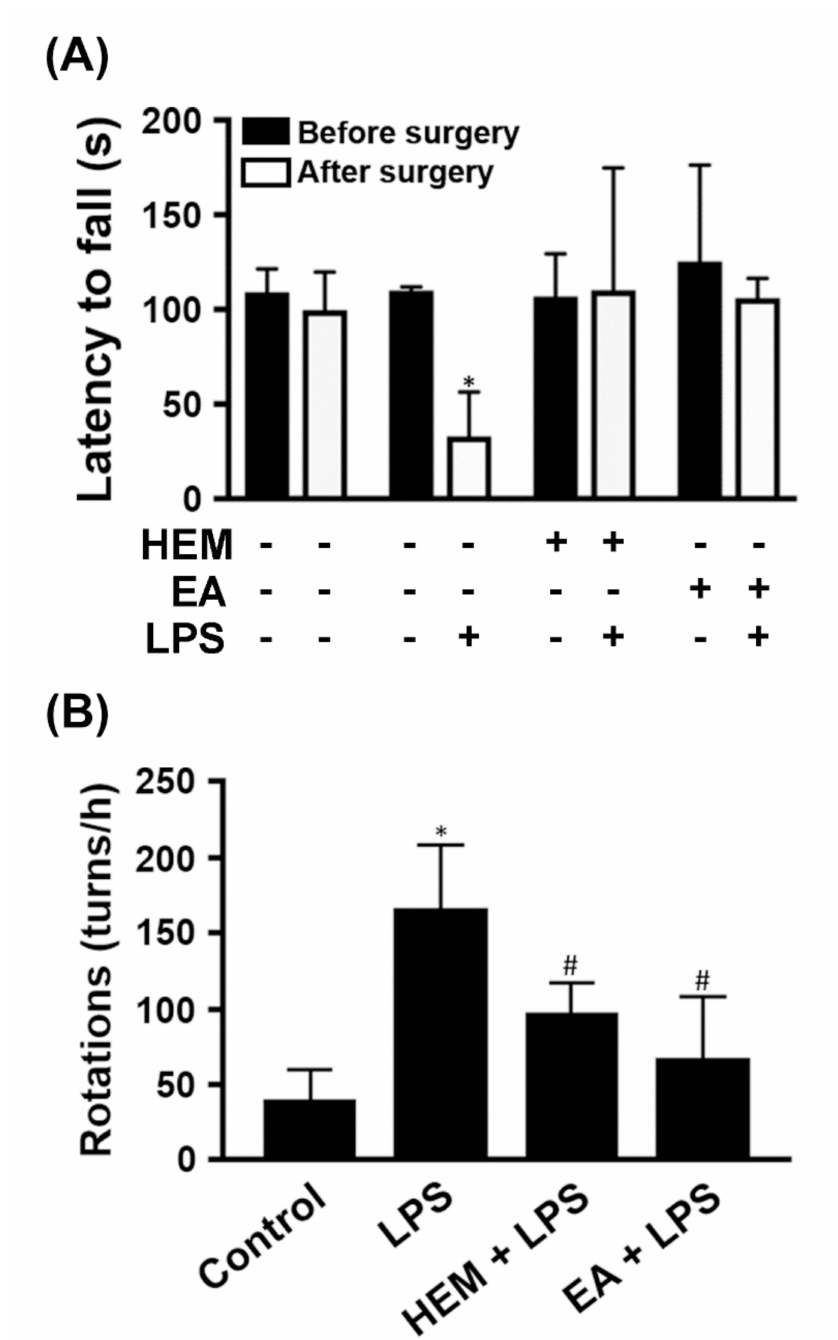
Figure 7. HEM or EA alleviates motor dysfunction in LPS-induced PD model rats. The rats were given vehicle, HEM (1 g/kg body weight), or EA (5 mg/kg body weight) by oral gavage once a day for 5 weeks and then they received a unilateral stereotaxic injection of LPS or PBS into the SN after the first week. ( A ) Rotarod performance analysis was performed before and after stereotaxic surgery. The amount of time the rats spent on the rotarod was measured. ( B ) After the rotarod test, the rats were tested for amphetamine-induced rotational behavior. The number of turns induced by amphetamine was recorded for 60 min. Data are presented as the mean ± SD of six rats per group. * p < 0.05 compared to the control group, # p < 0.05 compared to the LPS